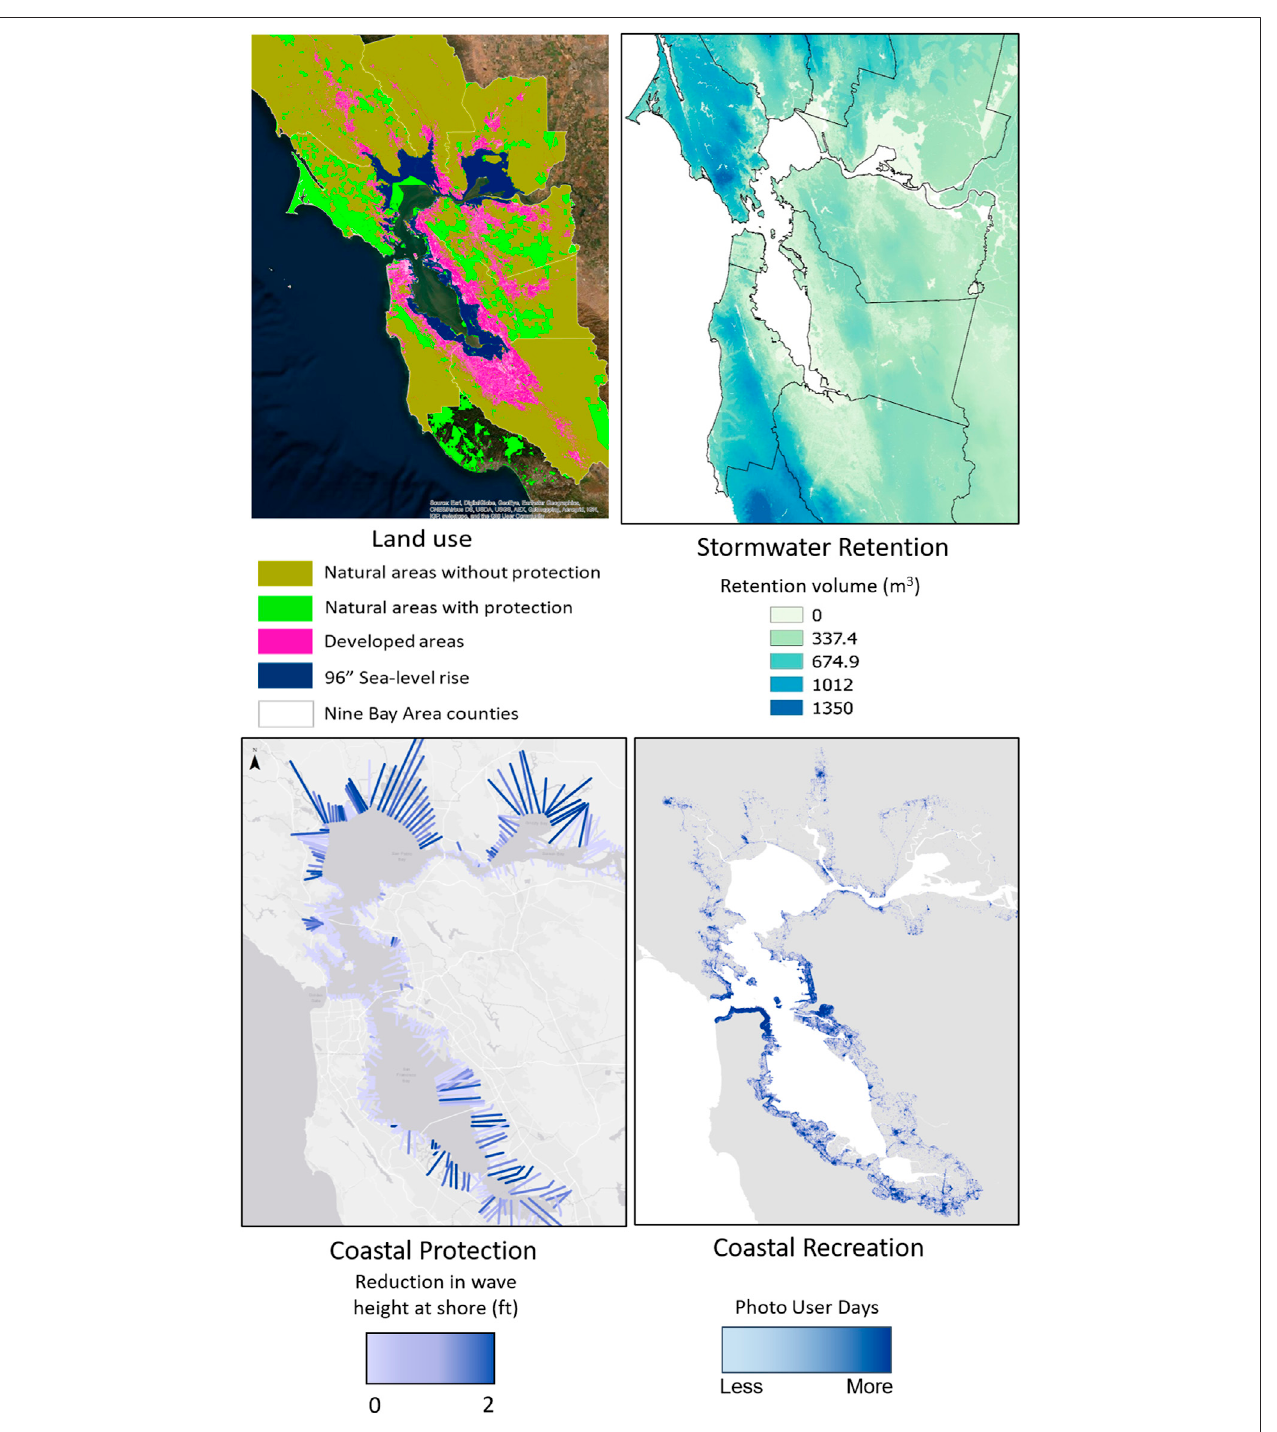
FIGURE 1 | Natural habitat and three ecosystem services (Stormwater Retention, Coastal Proetection, Coastal Recreation) quanti fi ed and mapped in the San Francisco Bay Area. The maps support discussions on current and expected changes in ecosystem services provision.